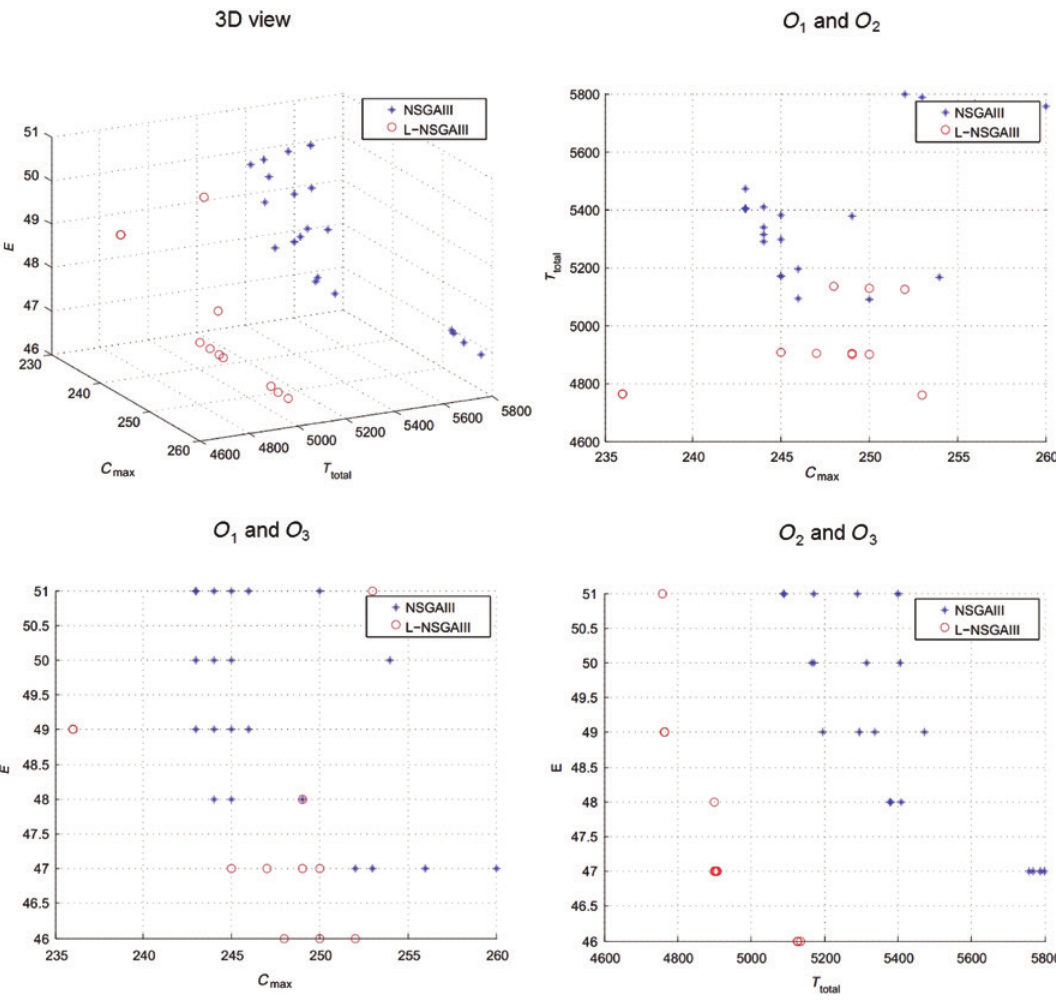
Figure 8: Example of Comparison Between NSGAIII and